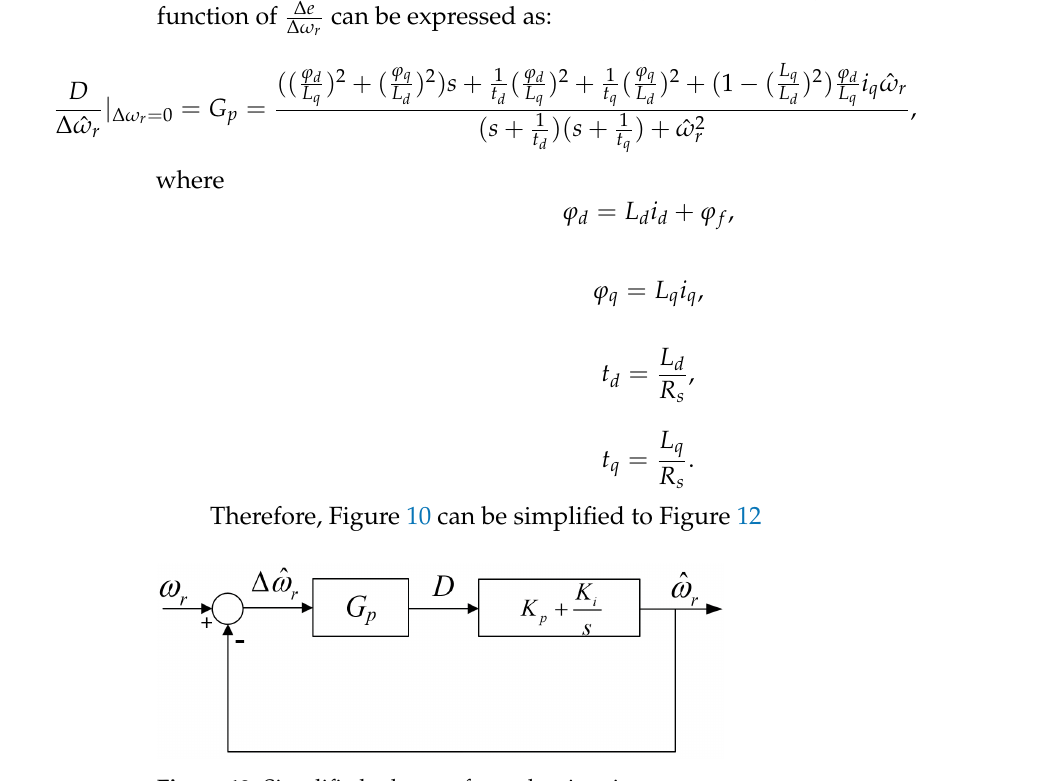
Figure 12. Simplified scheme of speed